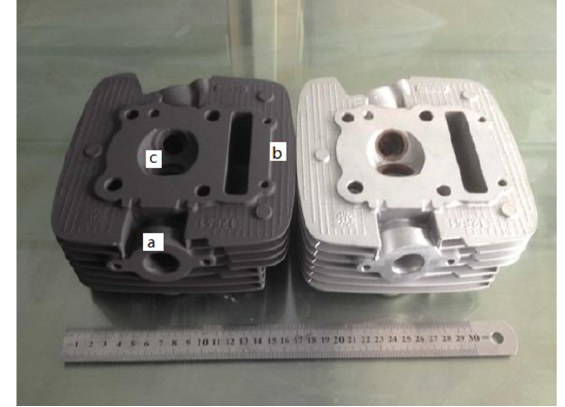
Figure 7. Experimental test cylinder.